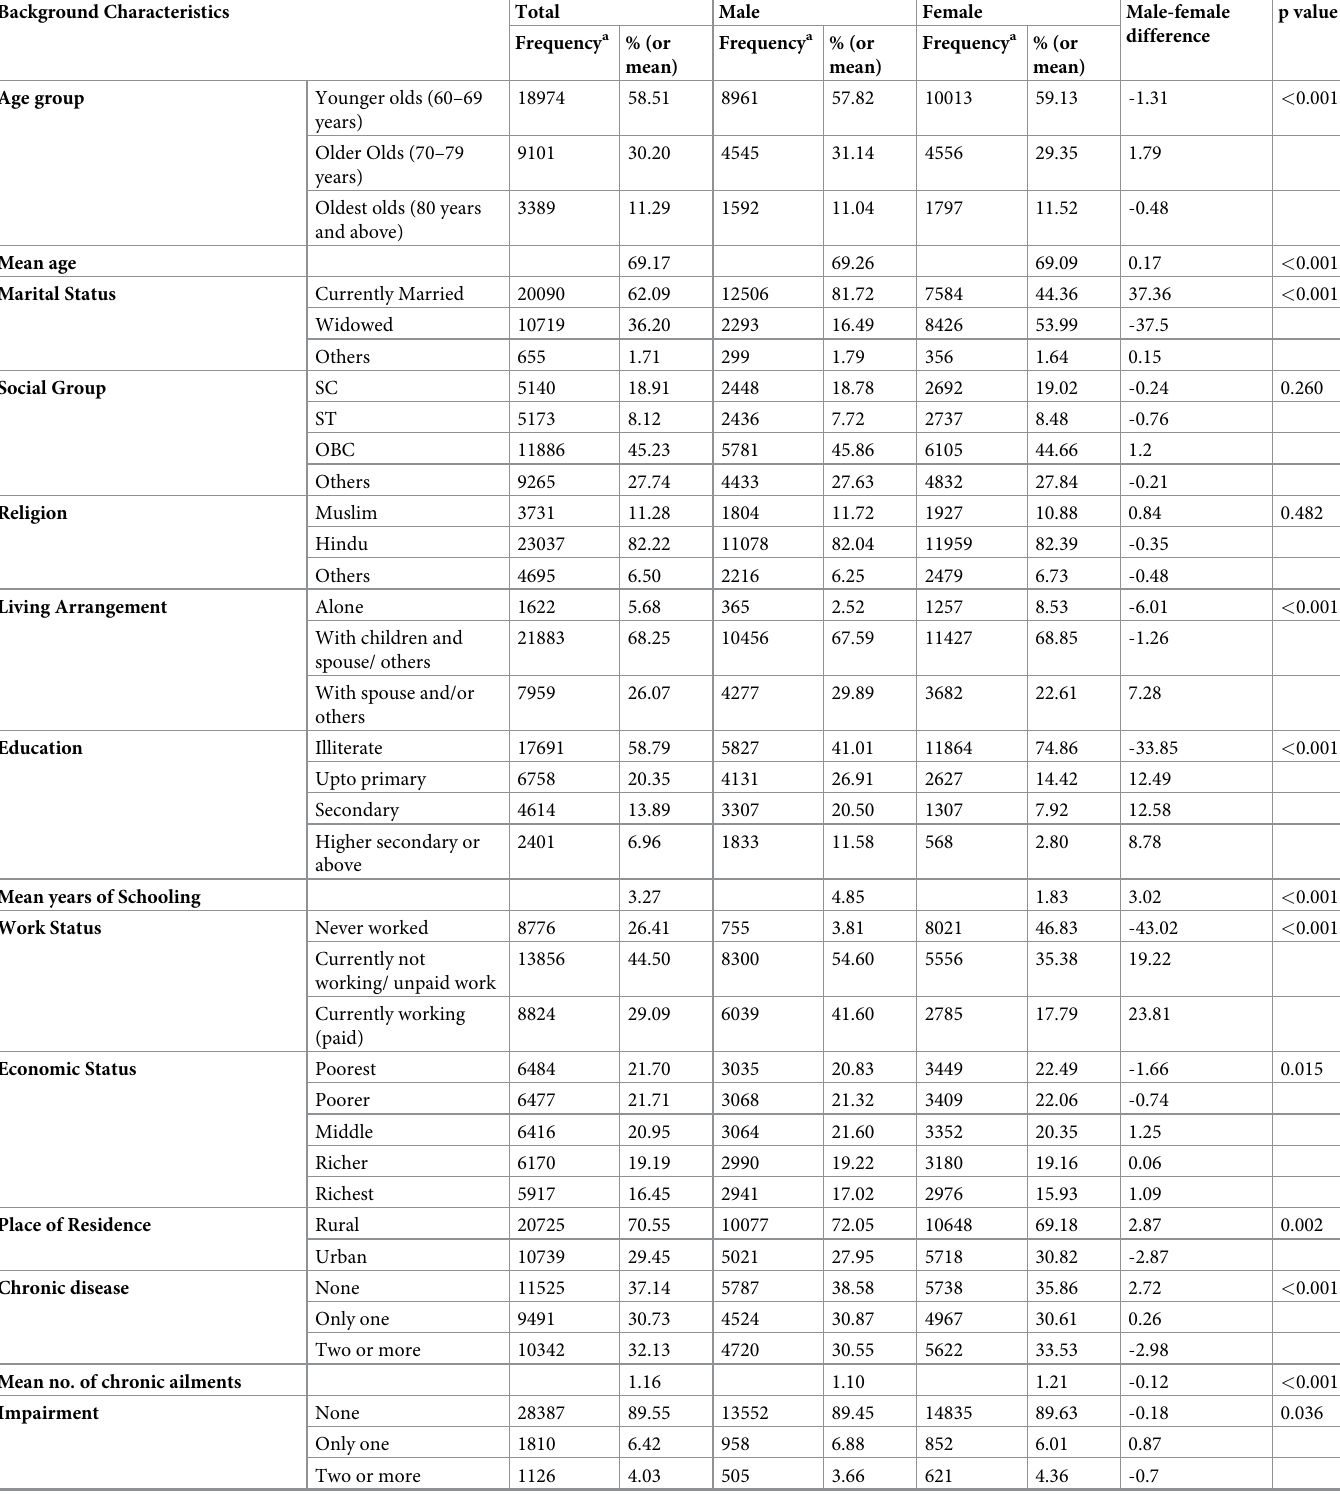
Table 1. Gender-wise distribution of the sample by select background